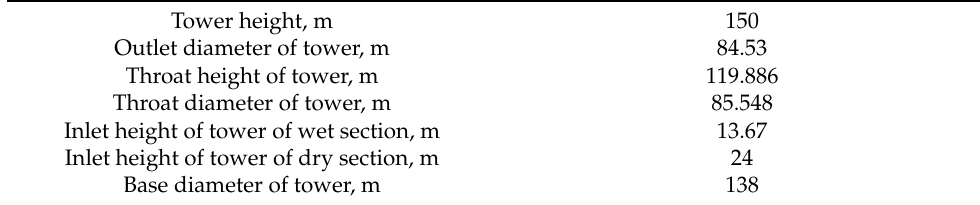
Table 3. Geometric parameters of the tower shell.